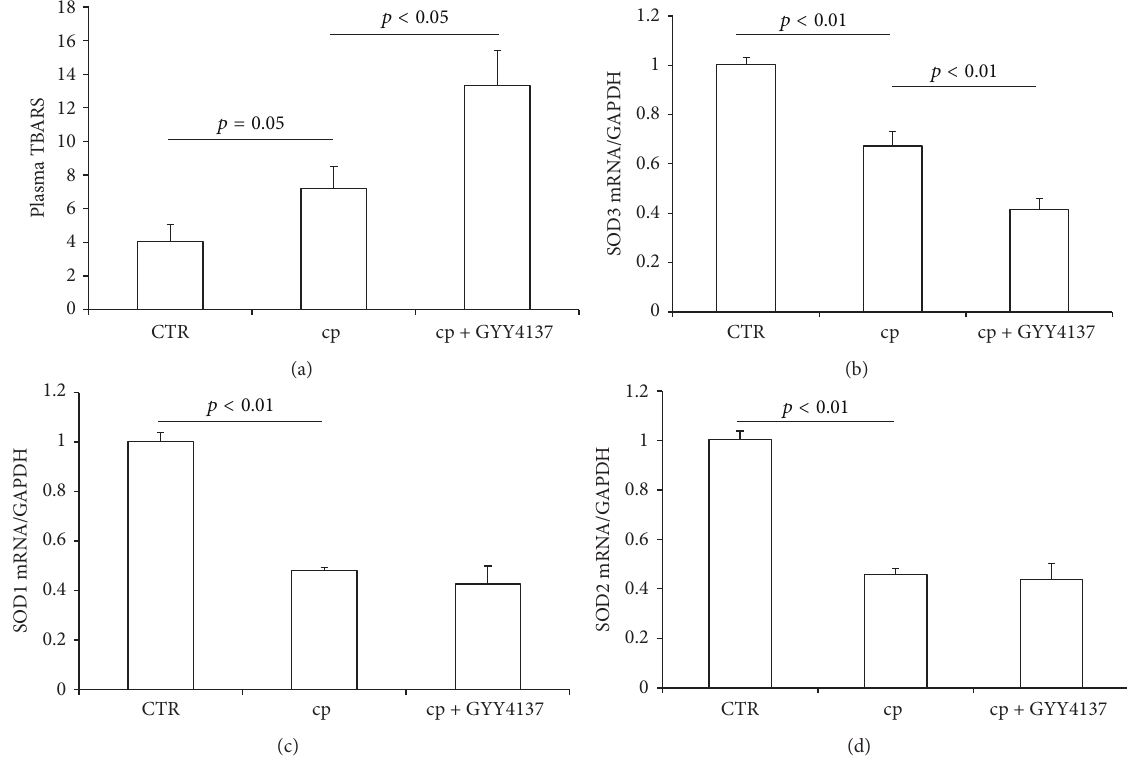
Figure 3: Effects of GYY4137 on cisplatin-induced oxidative stress. (a) Measurement of circulating thiobarbituric acid-reactive substances (TBARS) levels. (b) qRT-PCR analysis of renal SOD3 mRNA expression. (c) qRT-PCR analysis of renal SOD1 mRNA expression. (d) qRT- PCR analysis of renal SOD2 mRNA expression. CTR: control, 𝑛 = 5 ; cp: cisplatin, 𝑛 = 10 ; and cp + GYY4137: cisplatin + GYY4137, 𝑛 = 10 . Data are means ±